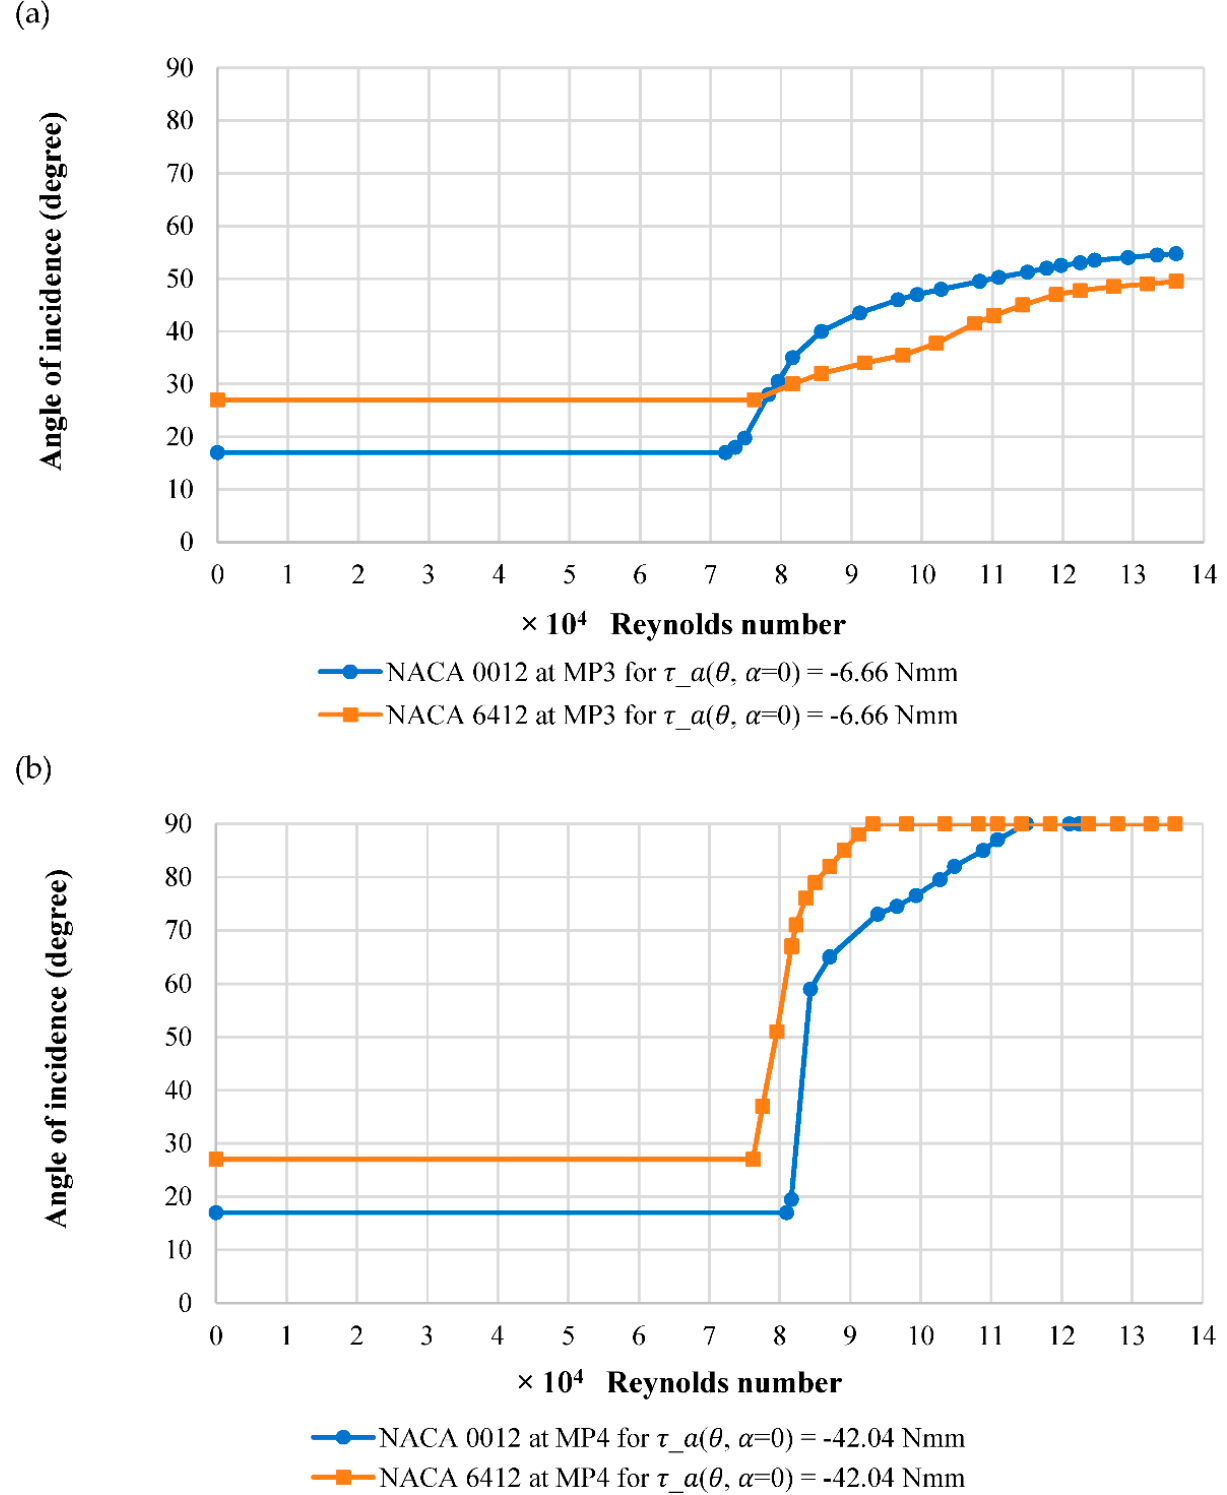
Figure 11. Effect of airfoil shape at ( a ) MP3 and ( b ) MP4.